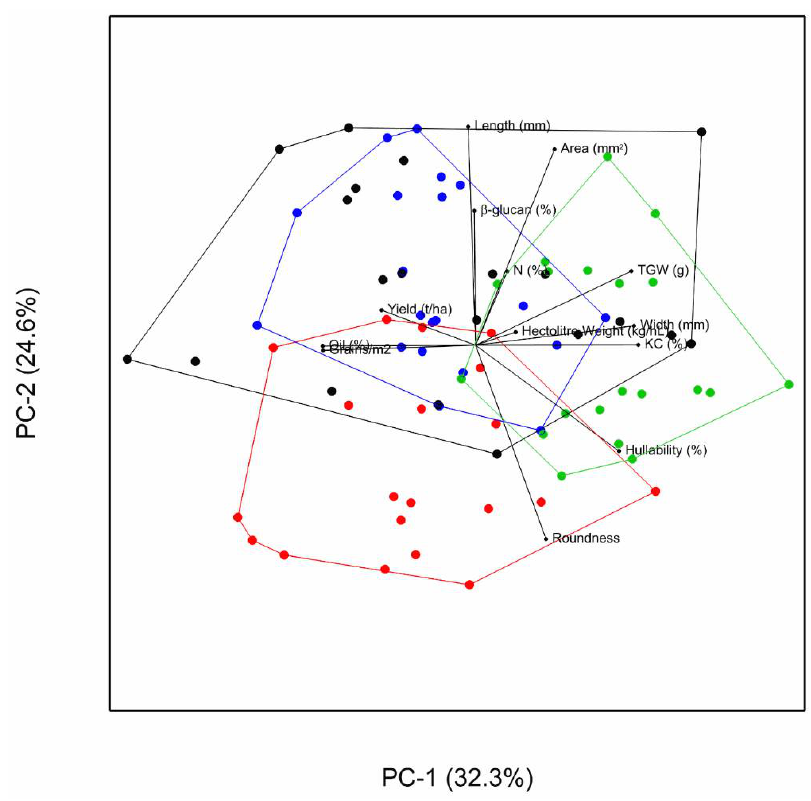
Figure 1. Principal component biplot of mean trait values for 4 winter oat varieties grown in 22 environments. KC: groat content, TGW, thousand grain weight. Balado—Black; Gerald—Red; Mascani—Green; Tardis—Blue.